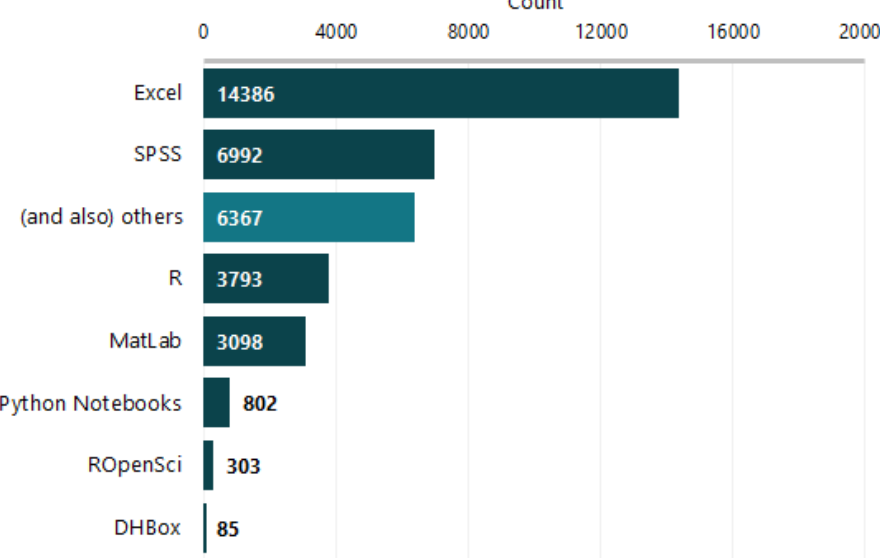
Figure 5: Fragment from the survey results demonstrating digital tools used for Analysis (source: https://101innovations.wordpress.com/survey-results/research-activities/analyze/).